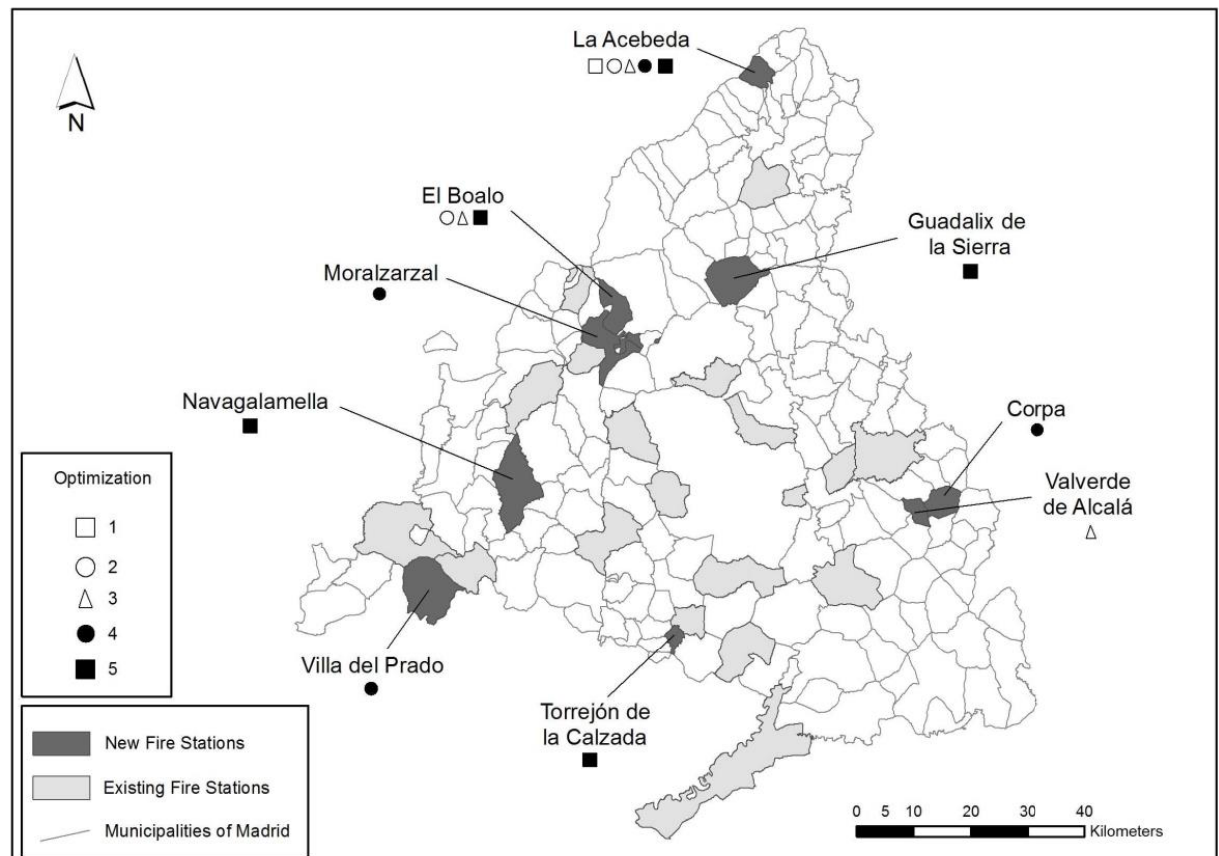
Figure 4. Municipalities of the new and old fire stations in the optimisation process.